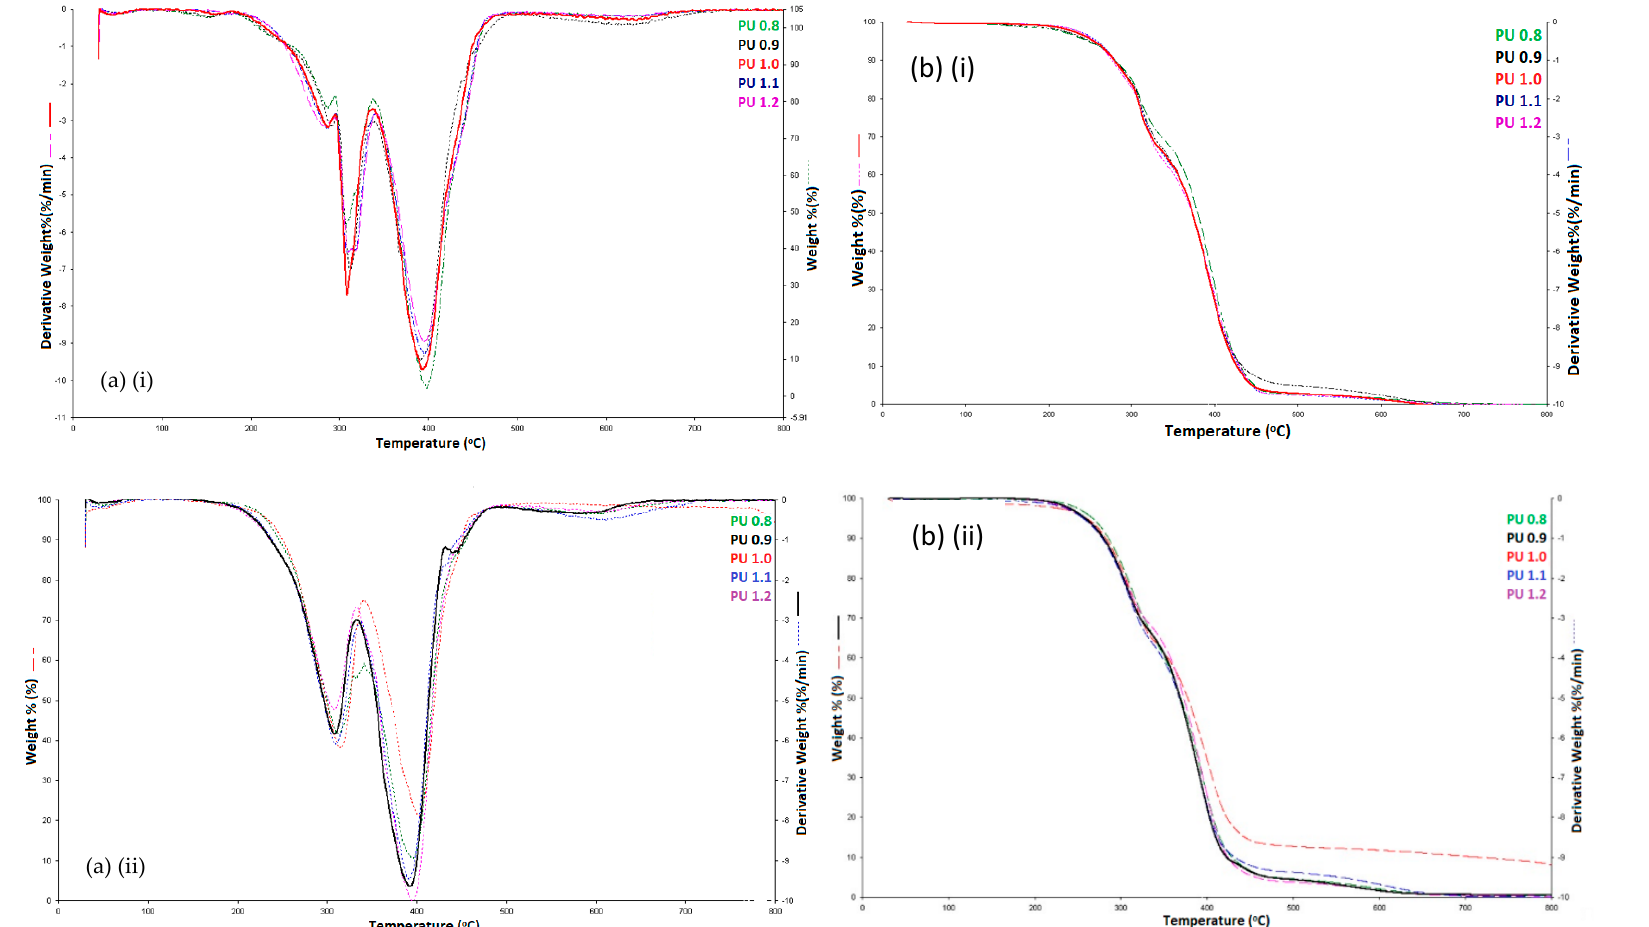
Figure 6. ( a ) DTG curves of polyurethanes produced by different isocyanate indices ( i ) Before degradation ( a ) ( ii ) After degradation and ( b ) TG curves of polyurethanes produced by different isocyanate indices ( i ) Before degradation ( b ) ( ii ) After degradation.